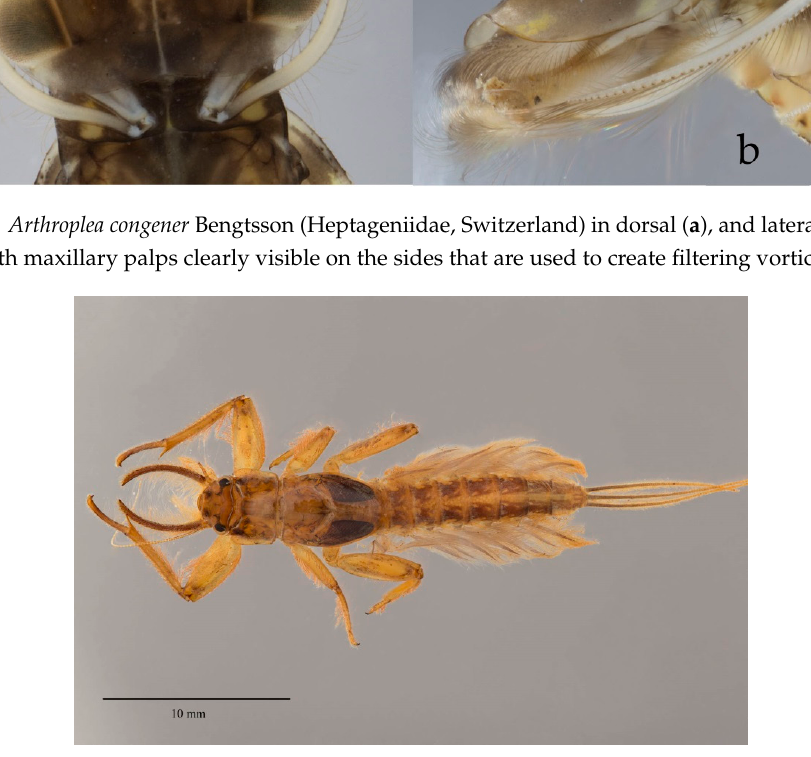
Figure 7. Ultimate larval instar of Polyplocia campylociella Ulmer (Euthyplociidae, Borneo) in dorsal view; a semi-burrower that uses its long mandibular tusks to dig soft substrate under cobble.